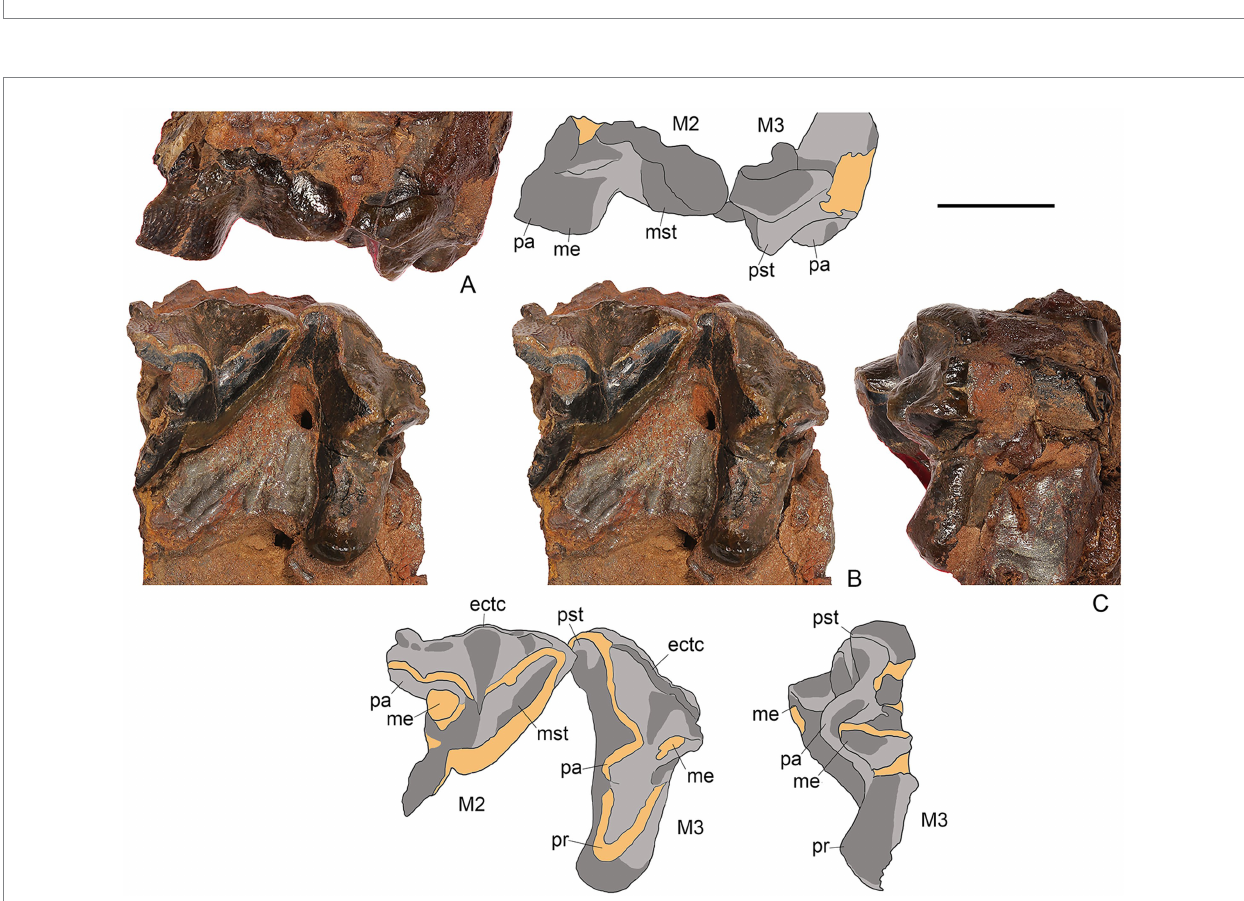
FIGURE 7 M. peregrinus , gen. et sp. nov., SYSU-M-5, holotype, left maxilla with M2-3, in labial (A) , occlusal [ (B) stereopair], and posterior (C) views (photographs and explanatory drawings). Youganwo Formation, upper Eocene, Maoming locality, Guangdong Province, China. ectc, ectocingulum; me, metacone; mst, metastyle; pa, paracone; pr, protocone; pst, parastyle. Scale bar equals 1